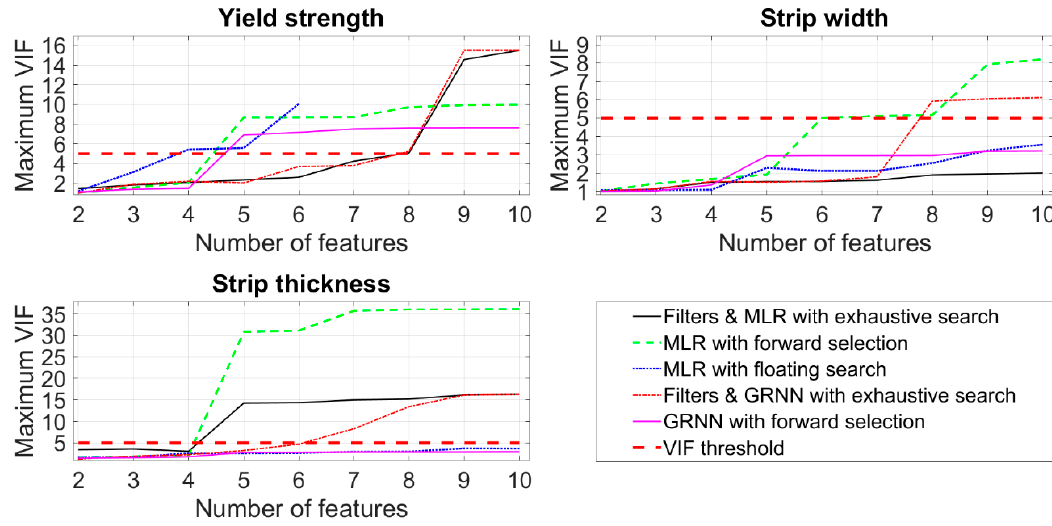
Figure9. Maximumvarianceinflationfactor(VIF)inthefeaturesubsetsselectedbydi ff Figure 9. Maximum variance inflation factor (VIF) in the feature subsets selected by different approaches.